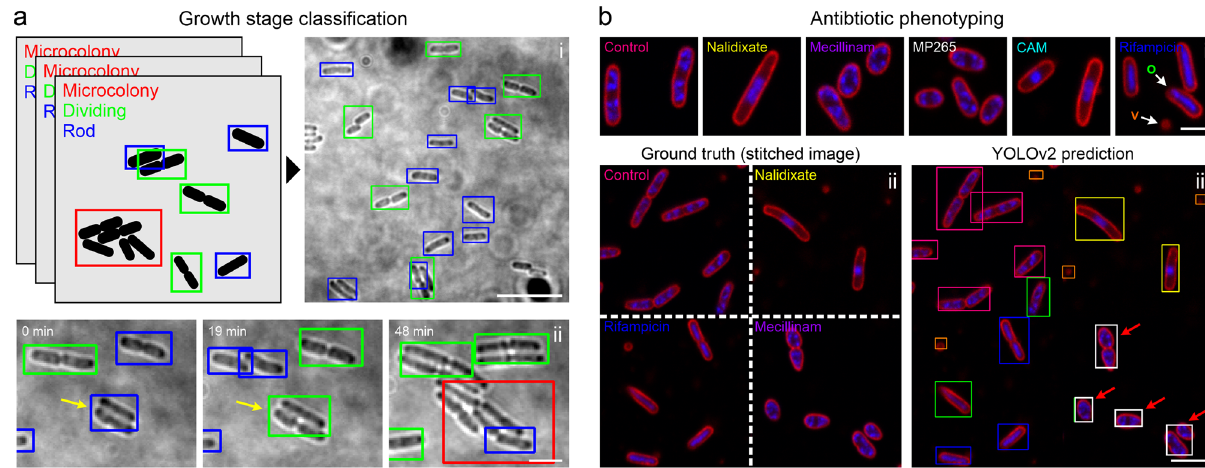
Fig. 3 DL-based object detection and classi fi cation. a A YOLOv2 model was trained to detect and classify different growth stages of live E. coli cells (i). “ Dividing ” cells (green bounding boxes) show visible septation, the class “ Rod ” (blue bounding boxes) represents growing cells without visible septation and regions with high cell densities are classi fi ed as “ Microcolonies ” (red bounding boxes). (ii) Three individual frames of a live cell measurement. b Antibiotic phenotyping using object detection. A YOLOv2 model was trained on drug-treated cells (i). The model was tested on synthetic images randomly stitched from patches of different drug treatments (ii). Bounding box colours in the prediction (iii) refer to the colour-code in (i). Vesicles (V, orange boxes) and oblique cells (O, green boxes) were added as additional classes during training. Mecillinam-treated cells were misclassi fi ed as MP265- treated cells (red arrows). Scale bars are 10 µ m ( a , overview), 3 µ m (lower panel in a and b ) and 1 µ m ( b , upper